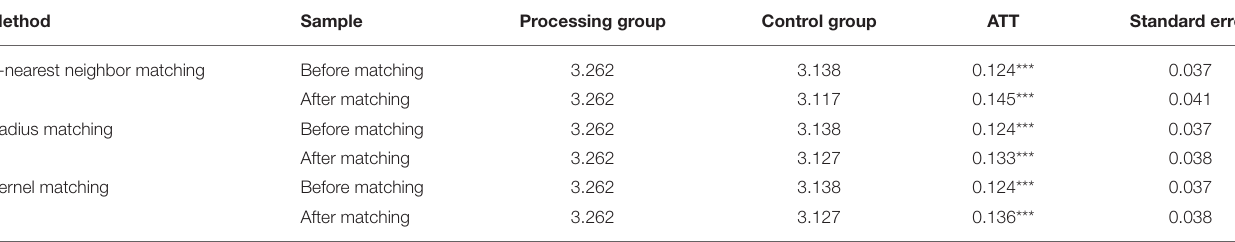
TABLE 5 | Average processing effect of participation in volunteer services on